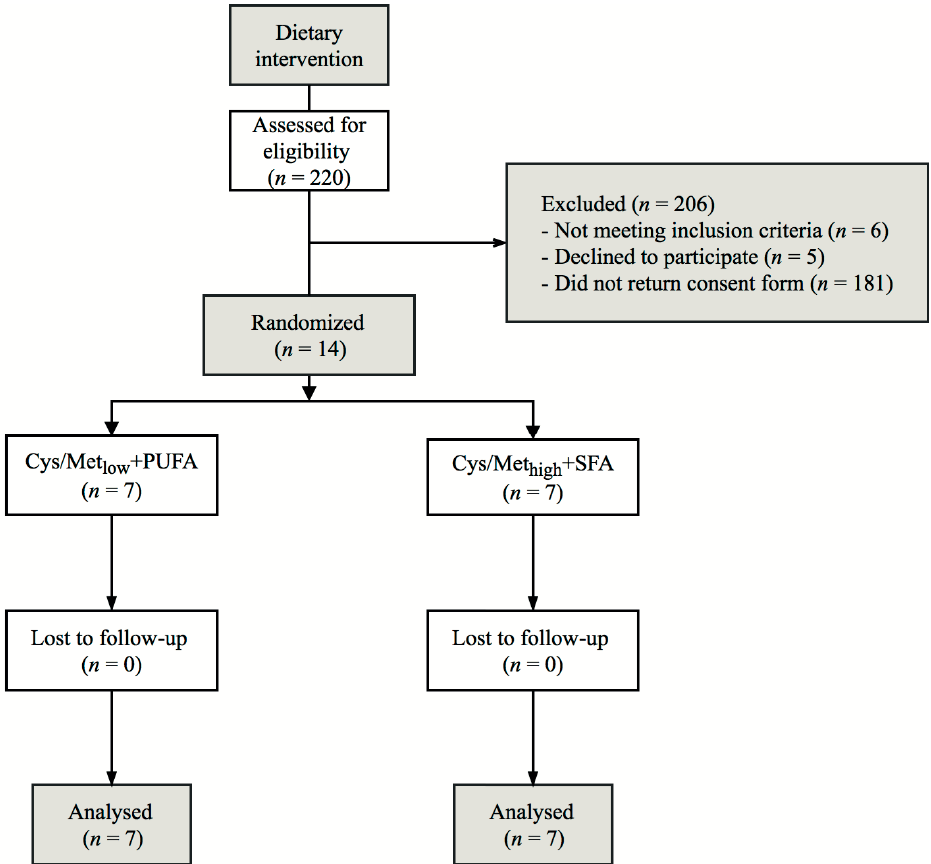
Figure 1. Flowchart outlining the study design and progression. Cys/Met low +PUFA, diet low in cysteine and methionine and high in polyunsaturated fatty acids; Cys/Met high +SFA, diet high in cysteine, methionine and saturated fatty acids.